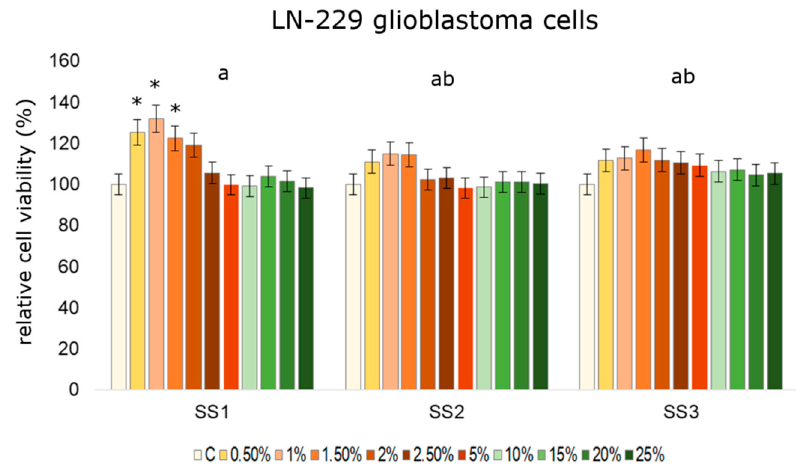
Figure 2. Cell viability results using MTT assay for LN-229 glioblastoma cells exposed to three different types of SS filtrates (SS1, SS2, SS3) for 24 h calculated as a percentage of control, untreated cells. The same letters indicate insignificant differences between SS filtrates for analyzed cell line, assessed by Tukey’s test (p < 0.05). * p < 0.05, ** p < 0.01, *** p < 0.001 represent significant effects between treatments and control followed by Dunnett’s test.